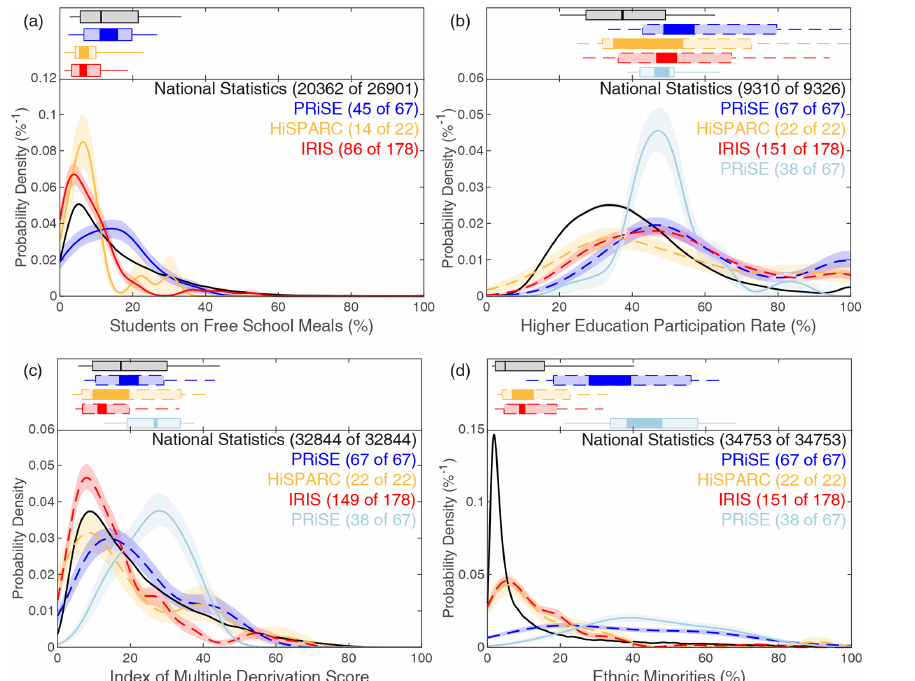
Figure 3. Distributions of (a) students on free school meals, (b) higher education participation rate, (c) index of multiple deprivation score, and (d) ethnic minorities. Box plots in (a) and (b) have whiskers covering 10%–90%, boxes spanning 25%–75%, and bands depicting the standard confidence interval in the median. Panels (c) and (d) show kernel density estimates along with bootstrapped standard confidence intervals. Dashed lines indicate that only local data is used, which does not cover the schools’ full catchment